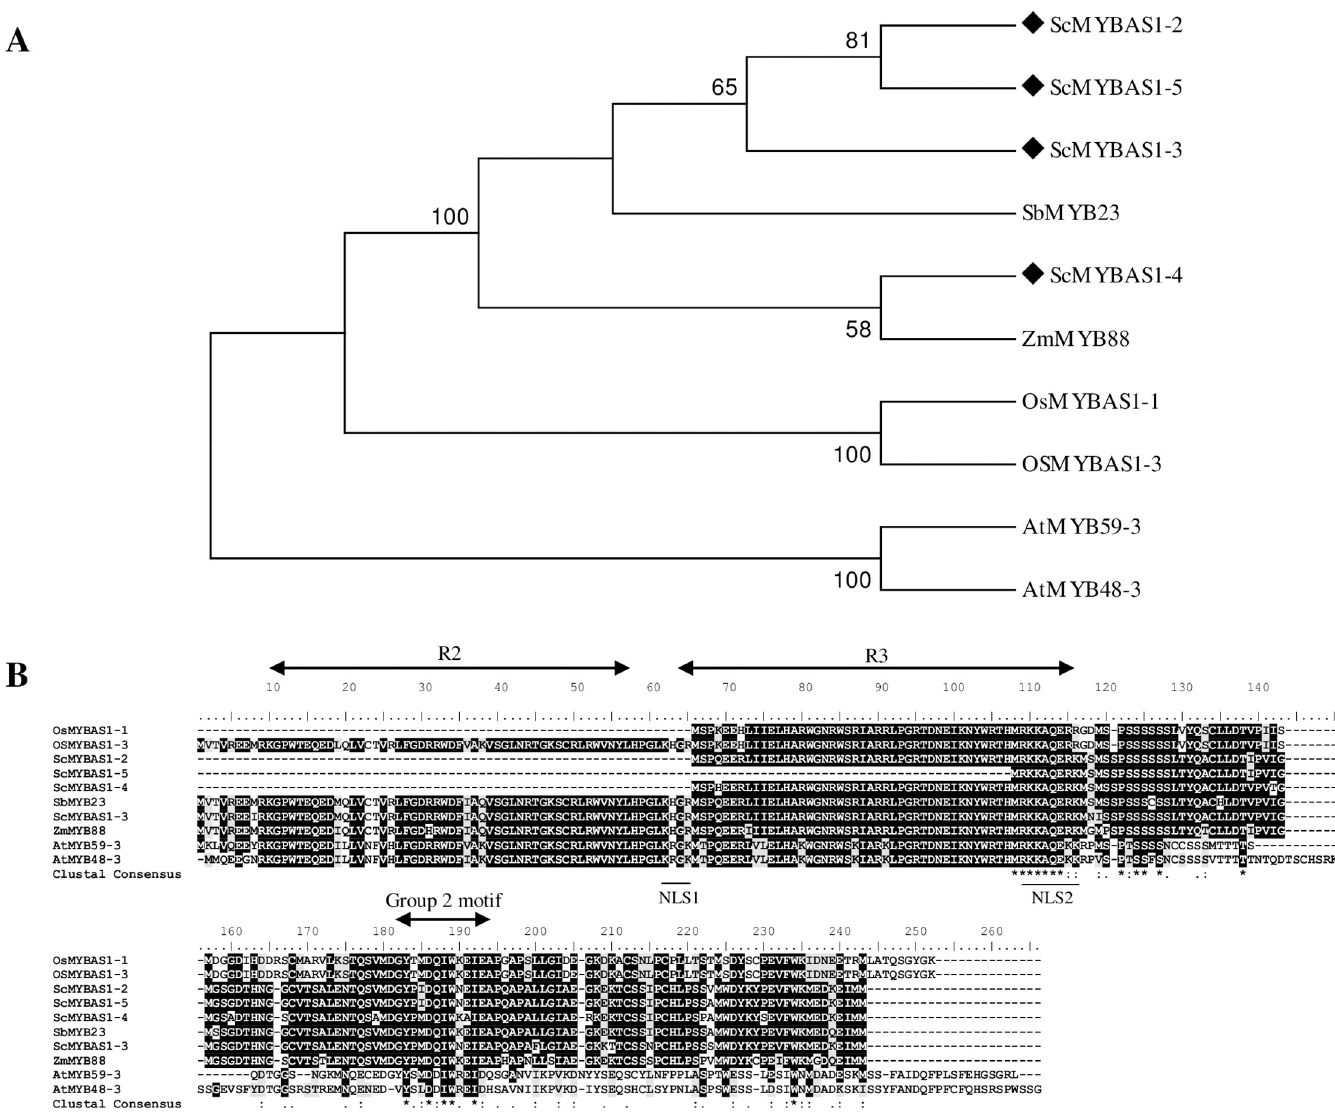
Fig 2. Dendrogram and sequence alignment of a subgroup of MYB protein sequences. (A) Dendrogram of a subgroup of MYB protein sequences from monocots and A . thaliana : ScMYBAS1-2 (MH052202), ScMYBAS1-3 (MH052205), ScMYBAS1-4 (MH052203), ScMYBAS1-5 (MH052201), SbMYB23 (Sobic.005G224800.1), ZmMYB88 (AFW60113.1), OsMYBAS1-1 (Q53NK6-2), OsMYBAS1-3 (AK111626), AtMYB59-3 (AT5G59780.3) and AtMYB48-3 (AT3G46130.1). Dendrogram was constructed with the parsimony method using MEGA 7, with a bootstrap of 100 samples. The branch numbers represent percentages of bootstrap. Sequence alignment of the proteins shown in (B). Identical amino acids are shaded in black, conserved changes in grey. The two MYB domain repeats (R2 and R3) and Group 2 motif are indicated with sets of arrows, and nuclear localization signals (NLS1 and NLS2) are indicated with black bars.